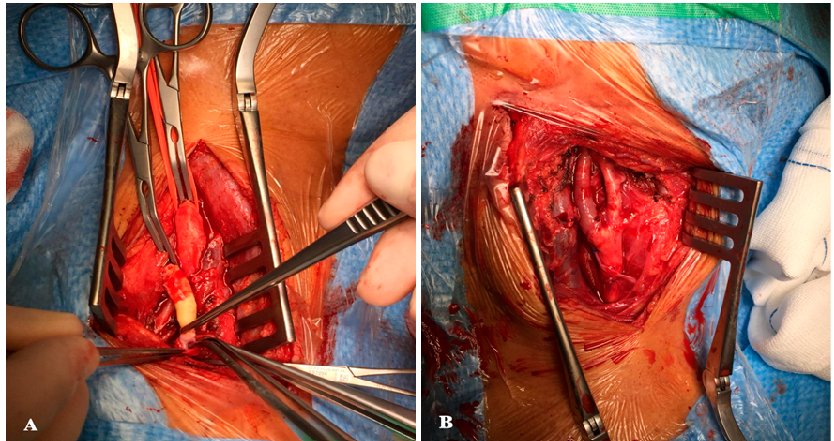
Figure 2. Carotid endarterectomy by eversion. ( A ) Transverse arteriotomy during endarterectomy by eversion with removal of the atheroma plaque. ( B ) Final reconstruction of the carotid bifurcation after eversion.